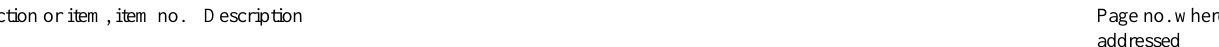
Table 2. Standard Protocol Items: Recommendations for Interventional Trials (SPIRIT) 2013 checklist: recommended items are addressed in this clinical trial’s protocol and related